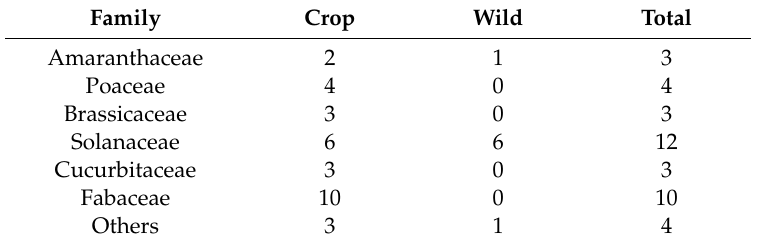
Table 2. Distribution of the analyzed plant species among botanical families and crop or wild plant categories. Family Crop Wild Total Amaranthaceae 2 1 3 Poaceae 4 0 4 Brassicaceae 3 0 3 Solanaceae 6 6 12 Cucurbitaceae 3 0 3 Fabaceae 10 0